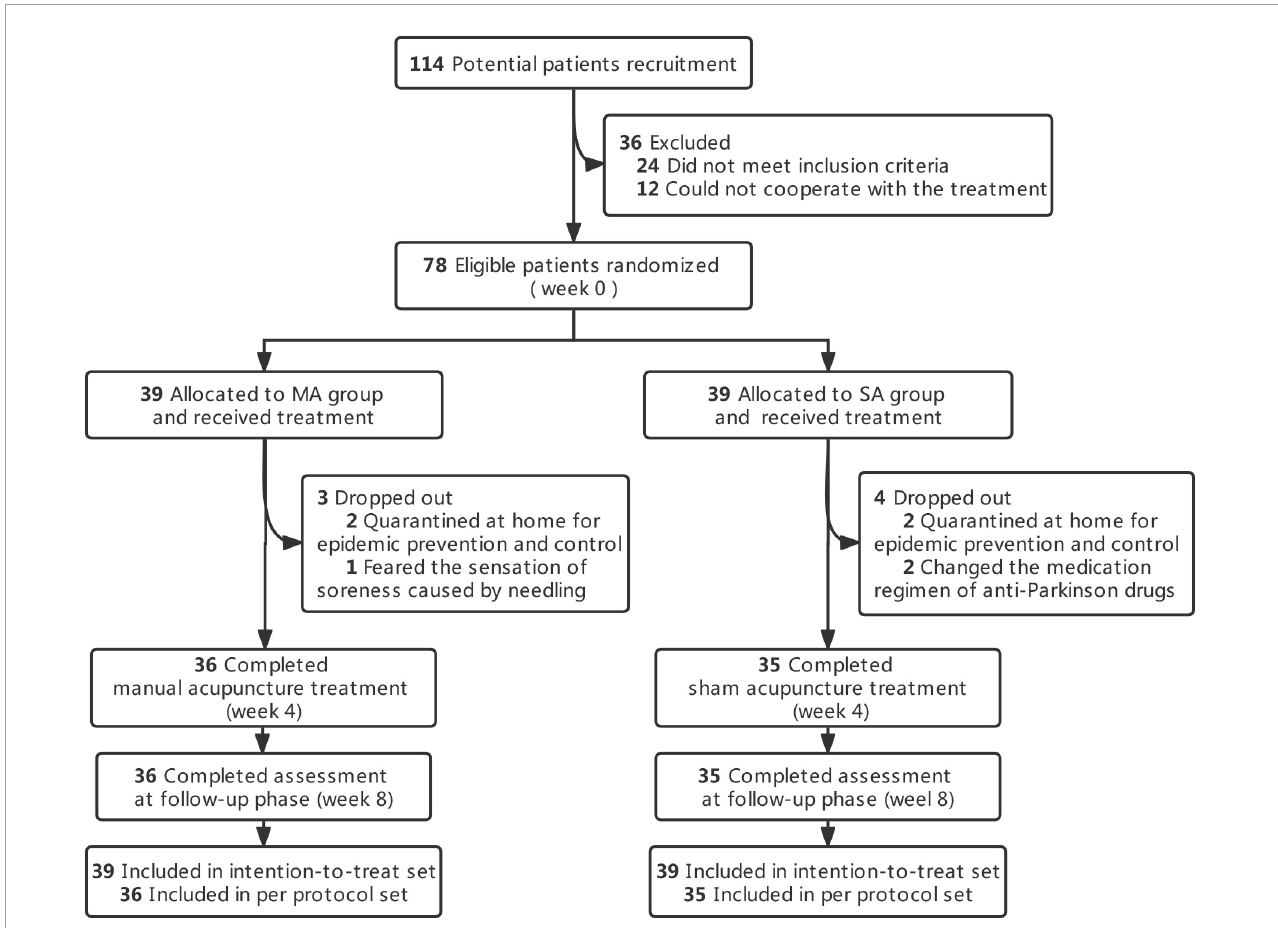
FIGURE1 The execution and dropout details. MA, manual acupuncture; SA, sham